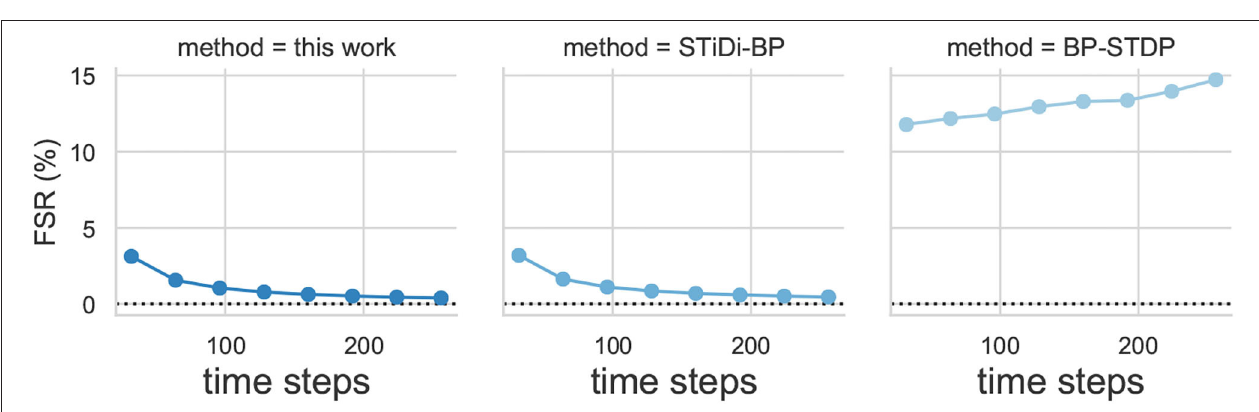
FIGURE 8 | The Inference test accuracy curve of the SNN trained with SSTDP method varies as the time steps.